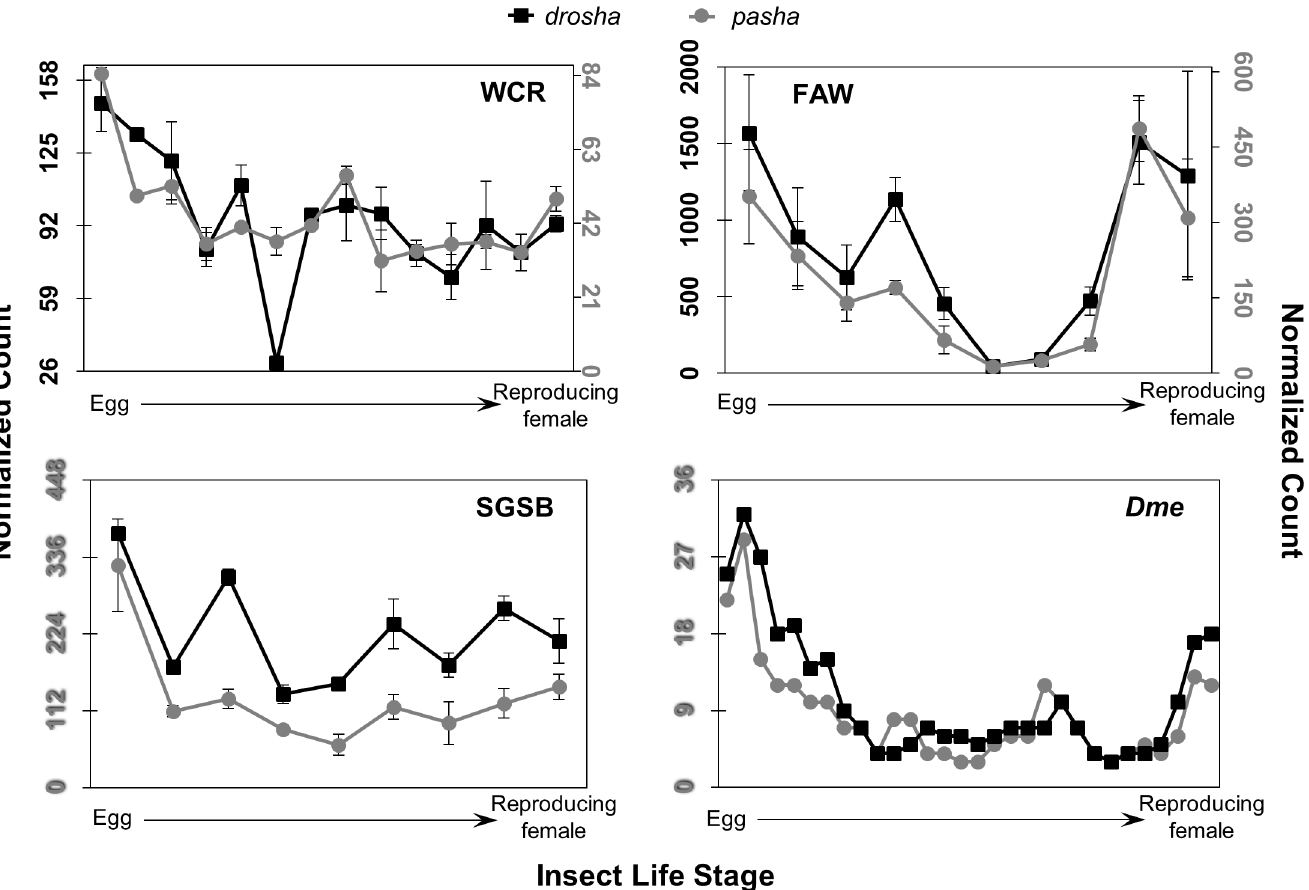
Fig 4. Expression patterns of drosha and pasha across insect life stage. WCR is shown at top left, FAW at top right, SGSB at bottom left, and Dme at bottom right, with drosha marked by black squares and pasha with grey circles. Normalized count for WCR, FAW, and SGSB transcripts was estimated using RSEM and modeled using DESeq2. The median value across sequencing samples (n = 2 to 4 for pest, n = 30 for Dme ) is shown, with error bars representing the median absolute deviation (MAD). Dme data were obtained from the modENCODE project [33, 34]. Normalized count (in reads per kilobase million) for Dme transcripts was generated by adjusting for read depth on a per million scale and length of each target gene in kilobases. Expression of drosha is scaled on the left axis in all graphs, and pasha on the right for WCR and FAW; axes colors also reflect gene target scaling. pasha-RA is shown for WCR and FAW, and– RAa for SGSB. Specific Dme isoforms are unknown.